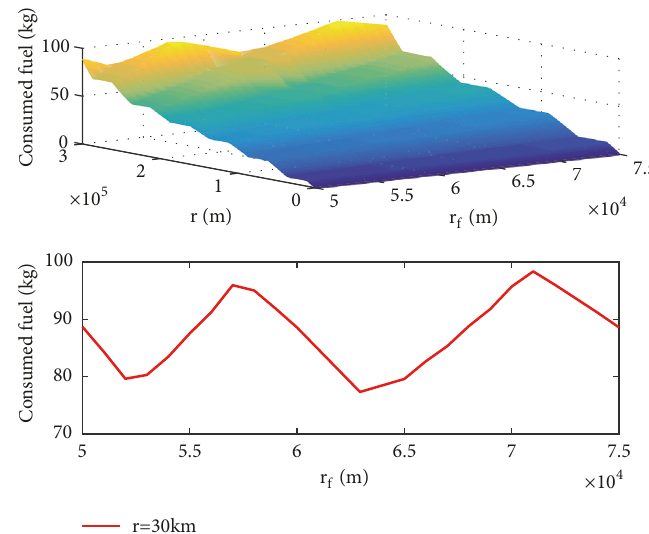
Figure 6: Consumed fuel with changes of adjusted parameter 𝑟 𝑓 and flight range 𝑟 .